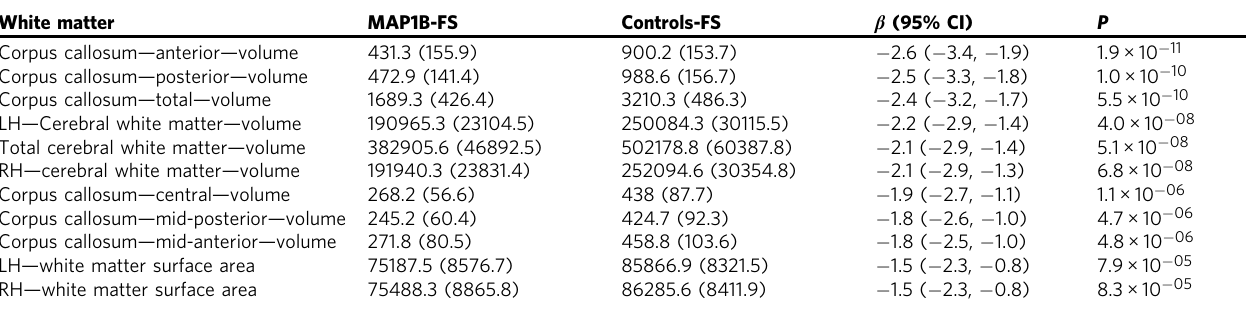
Table 3 Brain white matter differences in MAP1B LoF carriers compared with